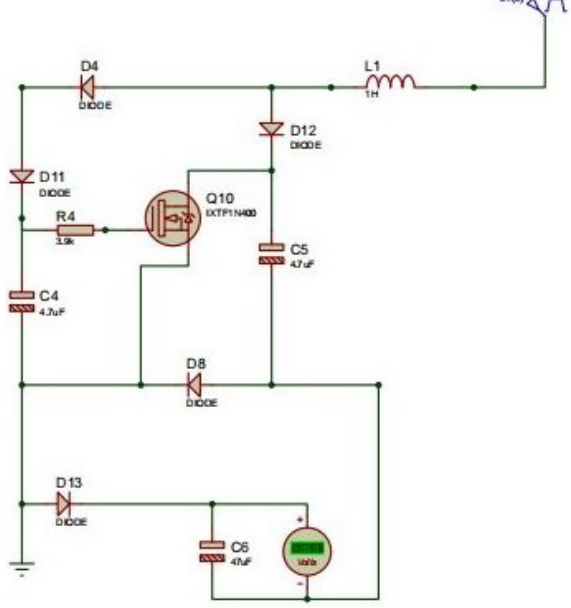
Figure 5. The single stage of the proposed modified Marx generator